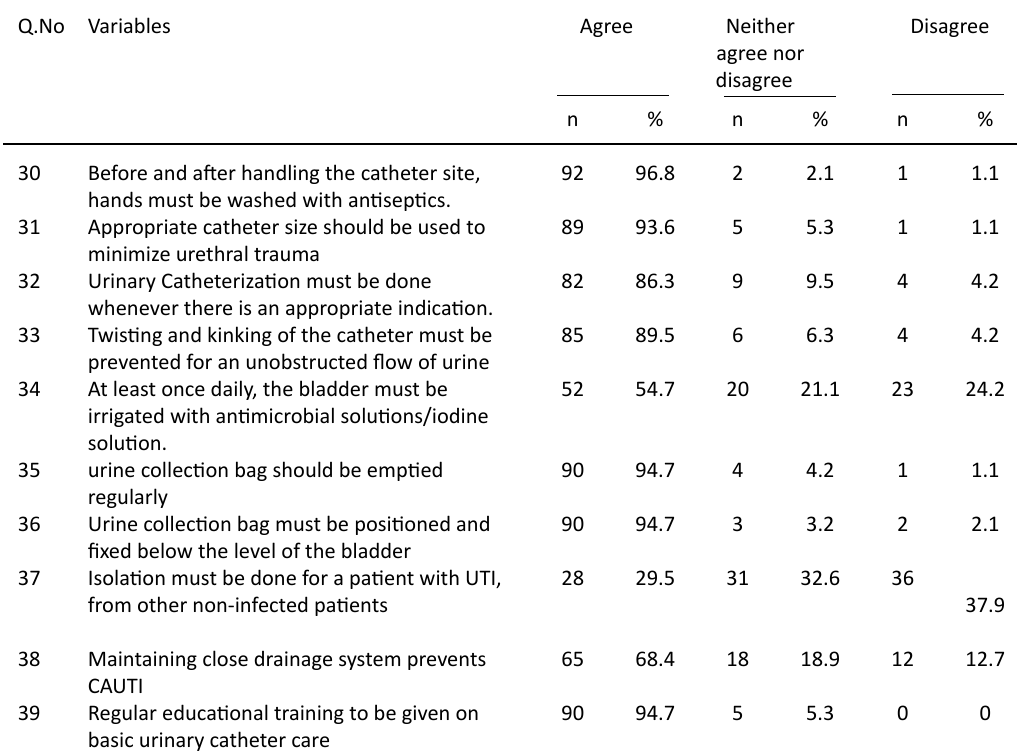
Table 5. Assessment of Practice on prevention of CAUTI among health care professionals (n=95) Q.No